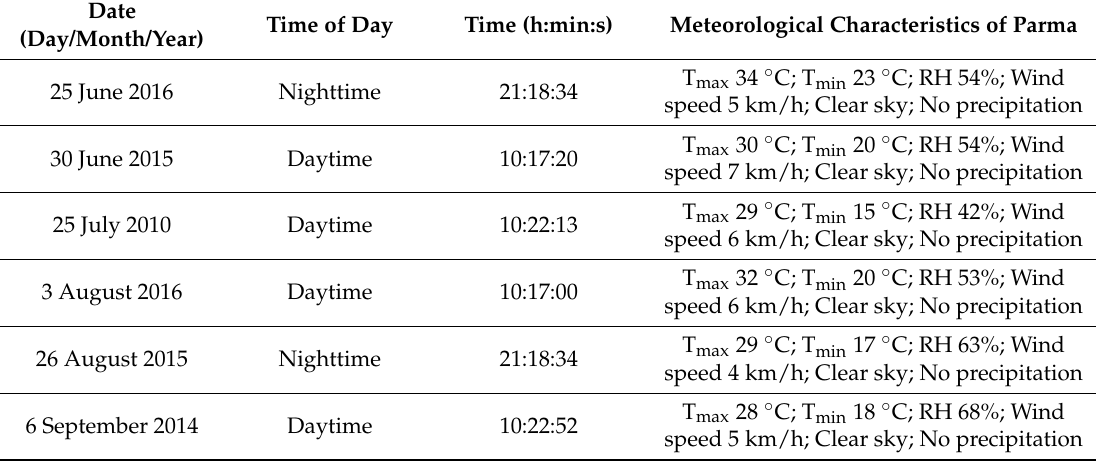
Table 1. The list of dates of the ASTER images selected and the corresponding daily meteorological characteristics of